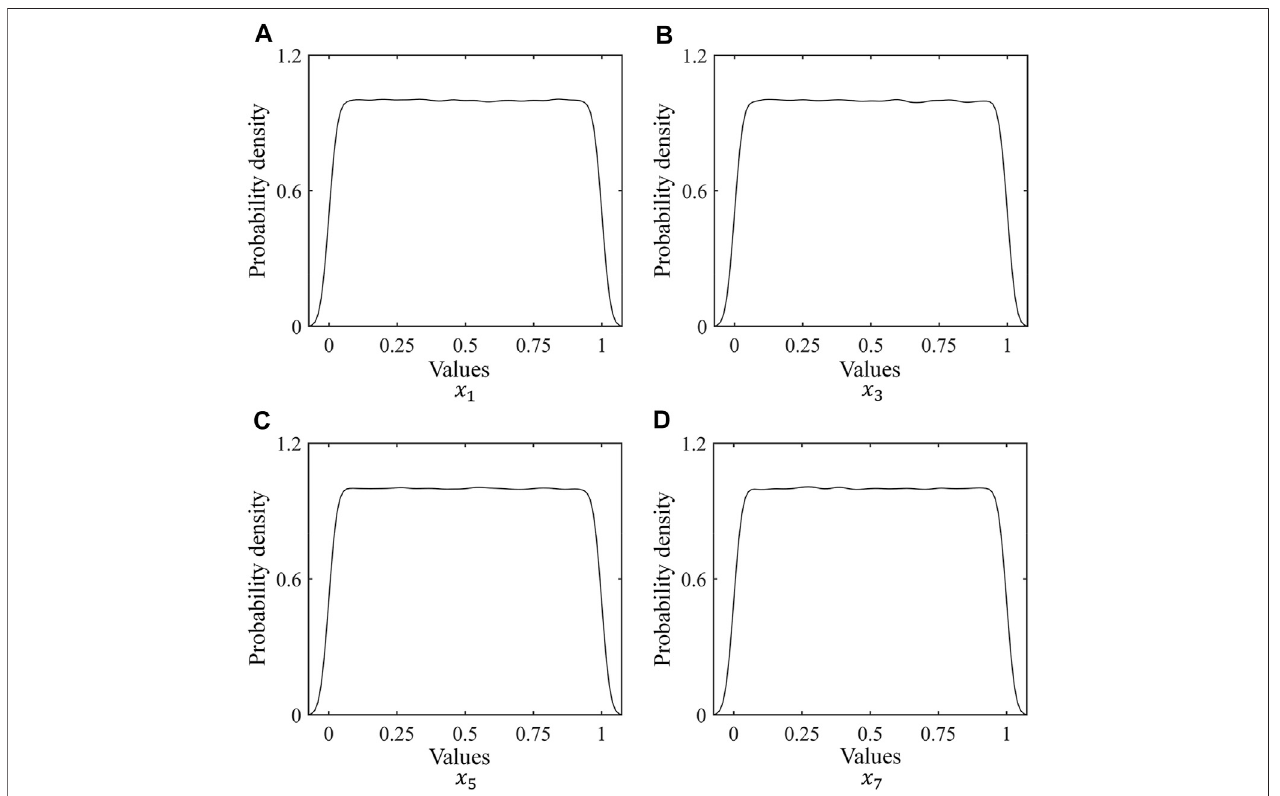
FIGURE 6 | Probability density distributions of output sequences after decorrelation operation. (A) , the probability density distributions of the above sequence x 1 . (B) , the probability density distributions of the above sequence x 3 . (C) , the probability density distributions of the above sequence x 5 . (D) , the probability density distributions of the above sequence x 7